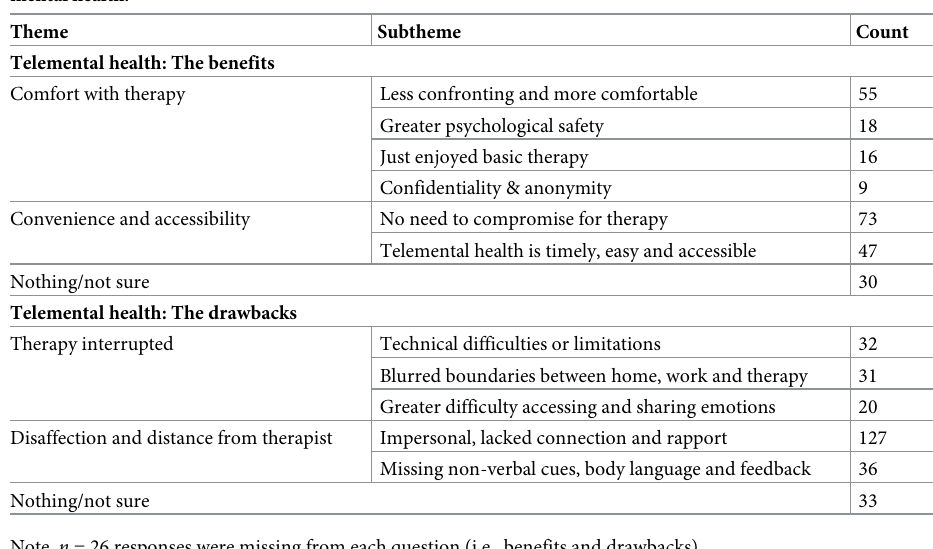
Table 3. Thematic representation and count of qualitative findings across positive and negative aspects of tele- mental